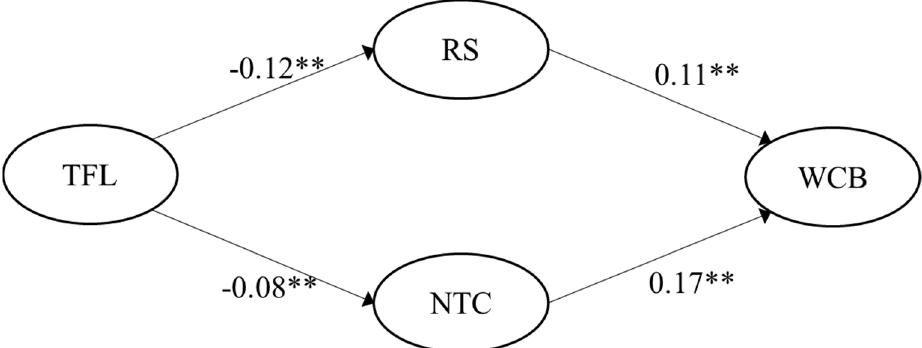
Figure 5. Empirical multiple mediation model for transformational leadership for the German sample (n = 334). Note: ** indicates a p ‐ value < 0.01; * indicates a p ‐ value < 0.05; TFL = Transformational leadership; RS = Role stress; NTC = Negative team climate; WCB = Workplace cyberbullying.